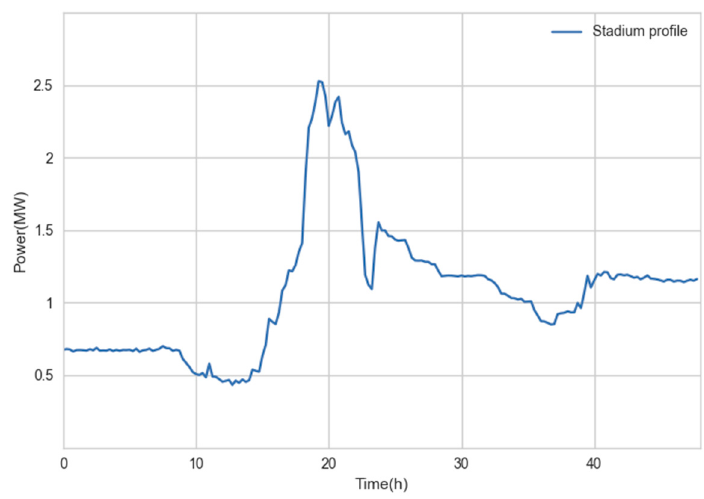
Figure 4. The load profile of the ArenA stadium used in the simulation studies.